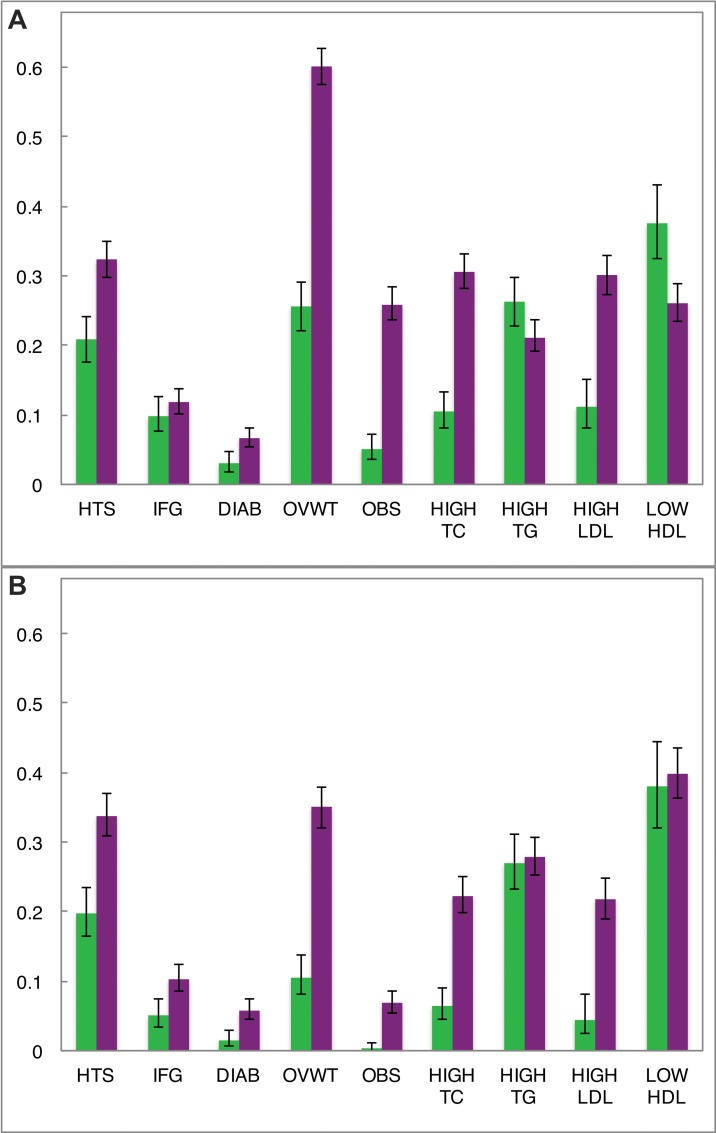
Age-standardized prevalence of dichotomous clinical outcomes by sex and urban/rural environment in Brong Ahafo, Ghana.(A) Urban (purple) and rural (green) females; (B) urban (purple) and rural (green) males. Error bars denote 95% confidence intervals of estimates. HTS: hypertension (SBP ≥140 or DBP ≥90); IFG: impaired fasting glucose (using the WHO cut-point of 110 mg/dL); DIAB: diabetes (glucose ≥126 mg/dL); OVWT: overweight (BMI ≥25); OBS: obesity (BMI ≥30); HIGH TC: hypercholesterolemia (cholesterol ≥200 mg/dL); HIGH TG: elevated triglycerides (≥ 110 mg/dL); HIGH LDL: elevated low-density lipoprotein cholesterol (≥130 mg/dL); LOW HDL: low high-density lipoprotein cholesterol (≤40 mg/dL). For UF, RF, UM, and RM, N = 1293, 583, 972, and 469 (except for HIGH LDL and LOW HDL: N = 955, 317, 722, 225), respectively. All data age-standardized to the WHO 2000–2025 standard population.